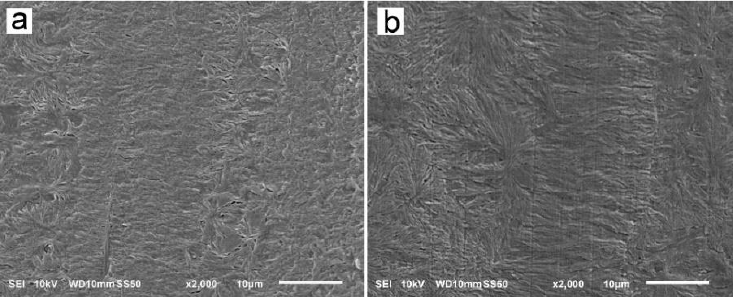
Figure 11. SEM micrographs of etched cross-section surfaces of L240 ( a ) and L121( b ) sheared at 150 °C at 20 /s for 5 s, and next cooled at 10 °C/min. Shearing direction — vertical.